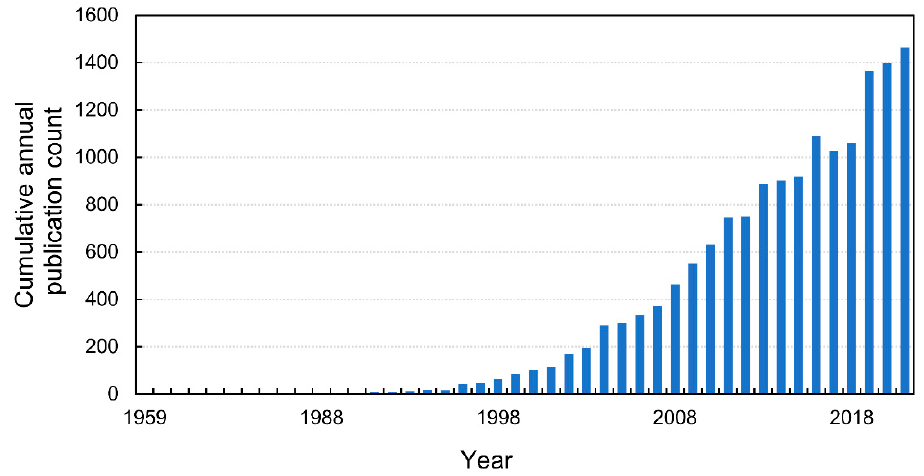
Figure 1. The cumulative annual publication count of papers on NO in plant science. Details of the search are available in the Supplementary Materials.